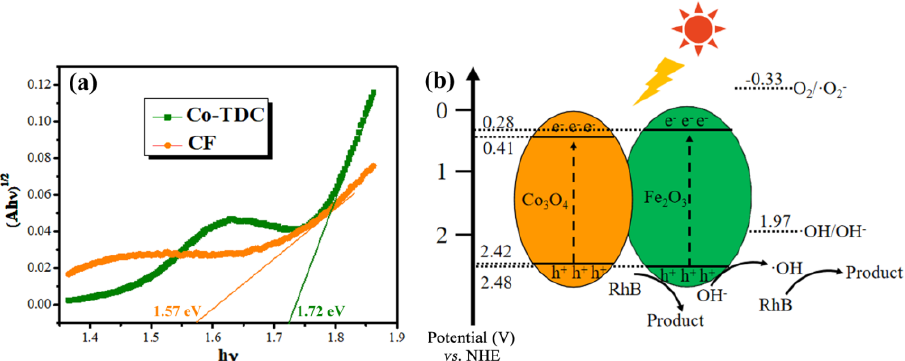
Figure 4. ( a ) Tauc plots, i.e., plots of ( αhν ) 0.5 vs. photon energy ( hν ), derived from diffuse-reflectance spectra of the Co-TDC and CF samples; ( b ) Band alignment and photocatalytic mechanism of the CF heterojunction under visible light illumination.